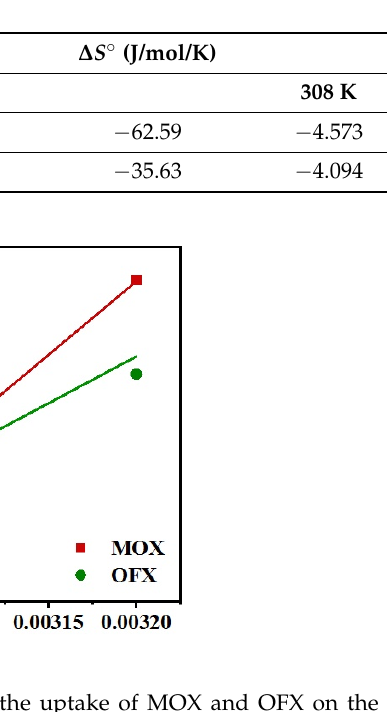
Table 5. Thermodynamic parameters of MOX and OFX adsorption onto Met-GO/SA at different temperatures (308–328